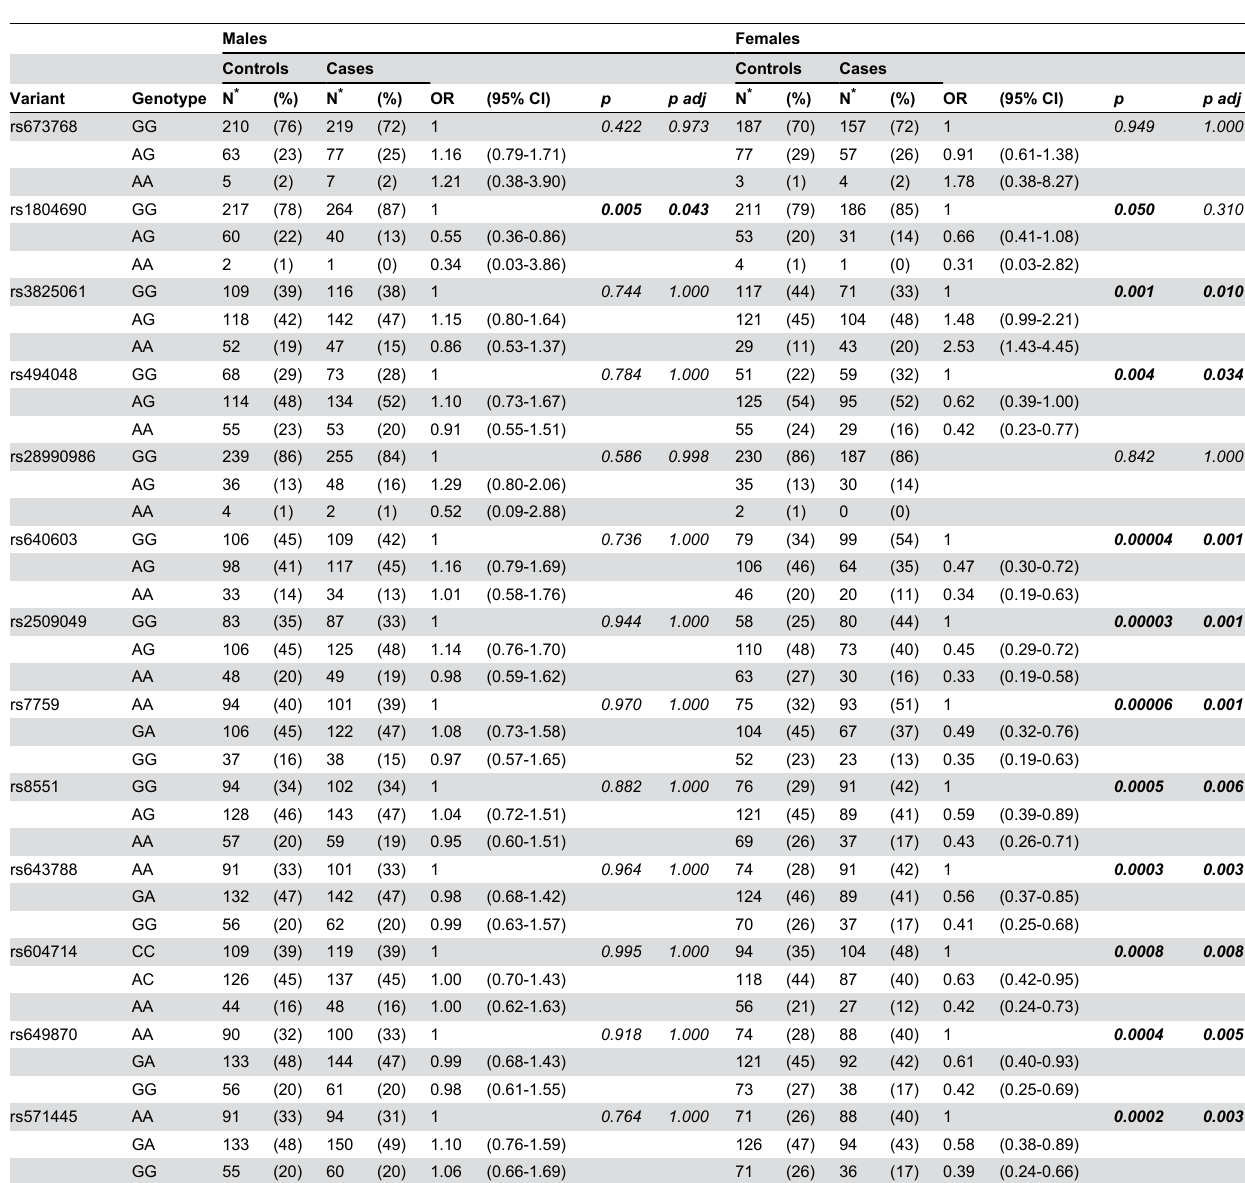
Table 4. Sex-specific association results for 13 SNPs in all B-cell lymphomas in the BC population.